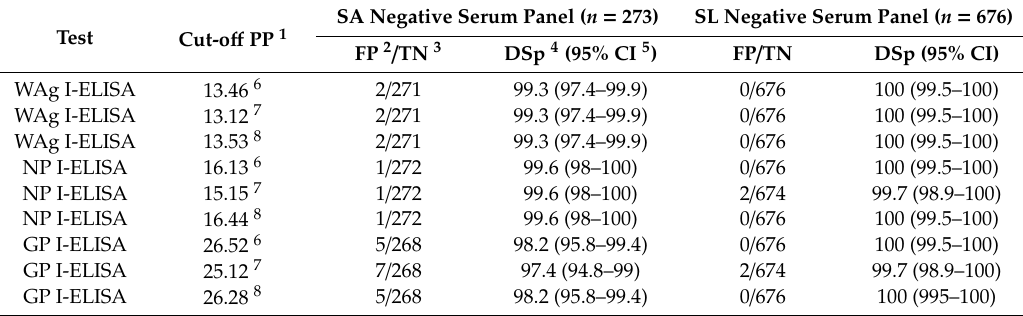
Table 2. Diagnostic specificity of whole antigen (WAg), nucleocapsid (NP), and glycoprotein (GP) indirect ELISAs for the detection of anti-IgG EBOV antibody in humans.